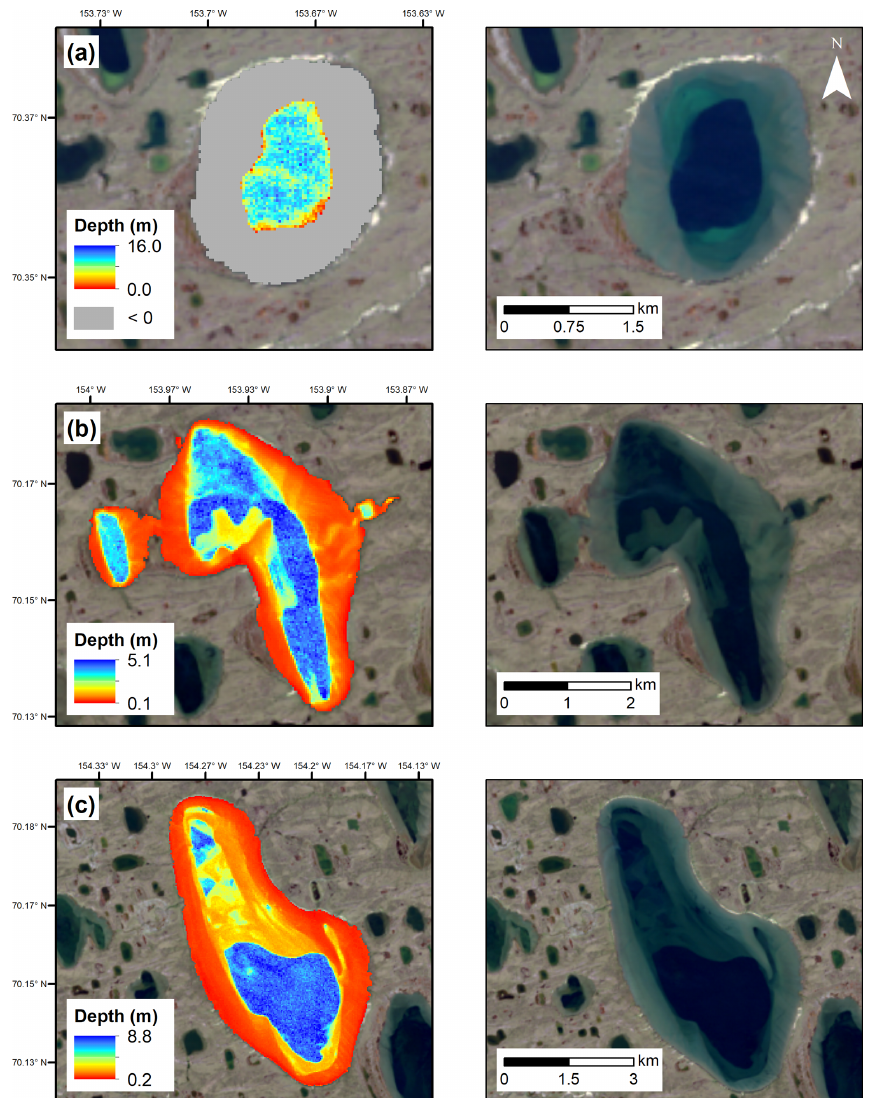
Figure 8. Modeled lake bathymetry at a representative lake (a) reveals the tendency of linear depth models to drastically underestimate the depths of the littoral shelves when not calibrated to shallow depths. Conversely, the exponential depth models applied to other lakes are promising across both littoral shelves and central basins (b, c) . The products of three different spectral-depth model variations are overlain on the Landsat imagery from which the products were derived. Adjacent to each depth product is the original Landsat imagery of the lake. Color bars indicate the depths predicted by the model variants at each lake, while the gray area (a) represents the pixels at which negative depths were modeled (these negative depths have been reclassified to − 1 in the published bathymetry raster dataset; Simpson, 2019). Landsat-8 image is courtesy of the US Geological